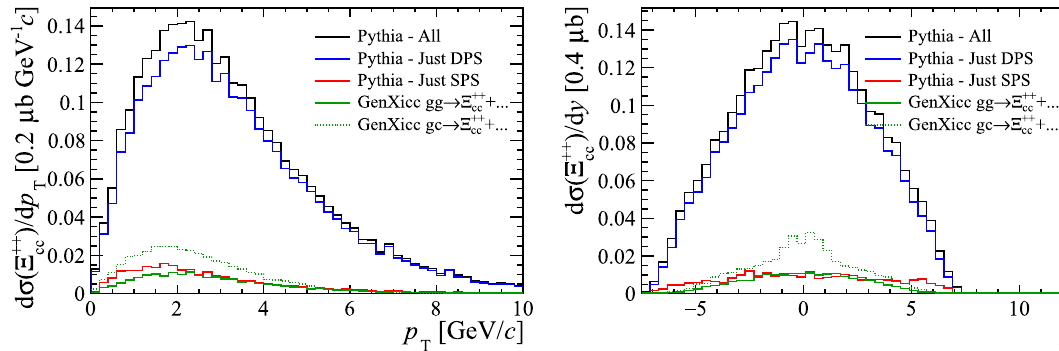
Fig. 12 Kinematic distributions of (cid:2) ++ cc baryons generated with Pythia and GenXicc